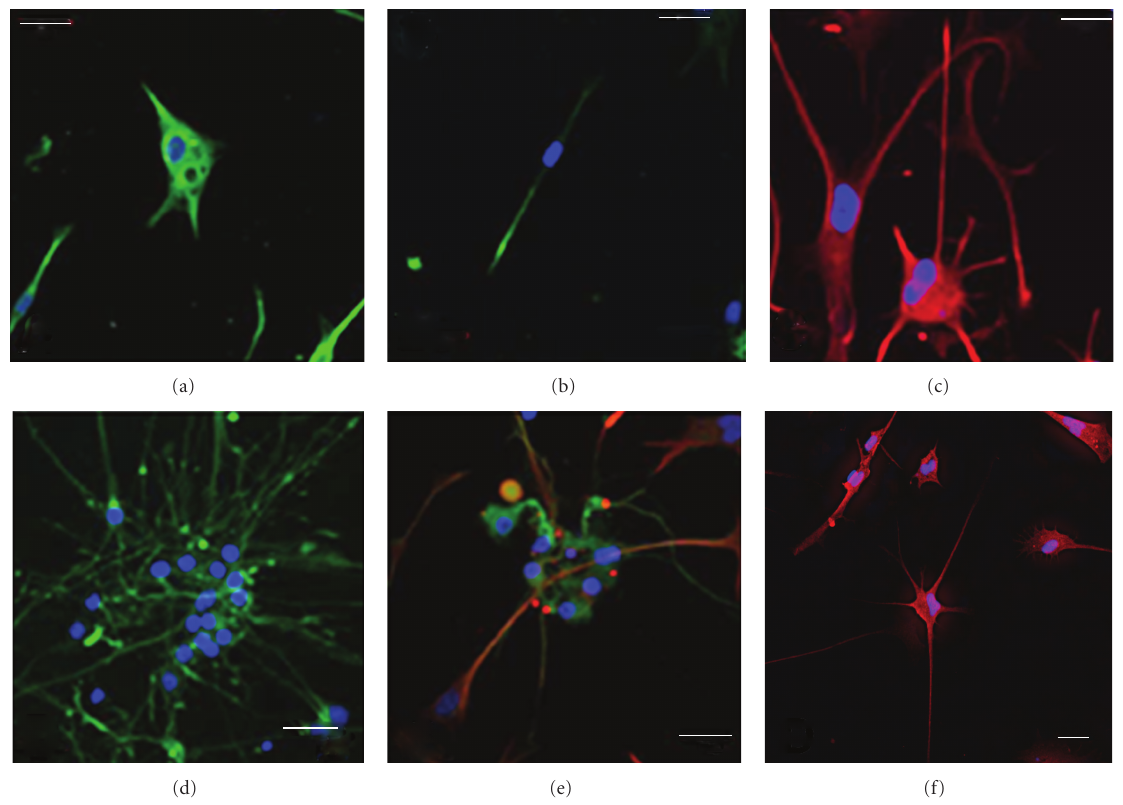
Figure 4: Di ff erentiated cells. Tumour stem cells from glioblastoma di ff erentiate into cells expressing aquaporins 1, 4, and 9 in addition to mature neuronal and glial markers. Yet, they retain their expression of immature markers. The cells displayed obviously aberrant morphology; note the multiple nuclei. (a, b): Di ff erentiated cells of both glial and neuronal morphology stained positively for aqp4 (green). (c) Cells also exhibited extensive positive signal for aqp9 (red). (d) Nestin positive cells (green). (e) Cells positive for TuJ1 (red) and GFAP (green) Some cells display labelling with both antigens (green and red, together). (f) Most di ff erentiated cells were positive for aqp1 (red). Scale bars: 20 μ m.